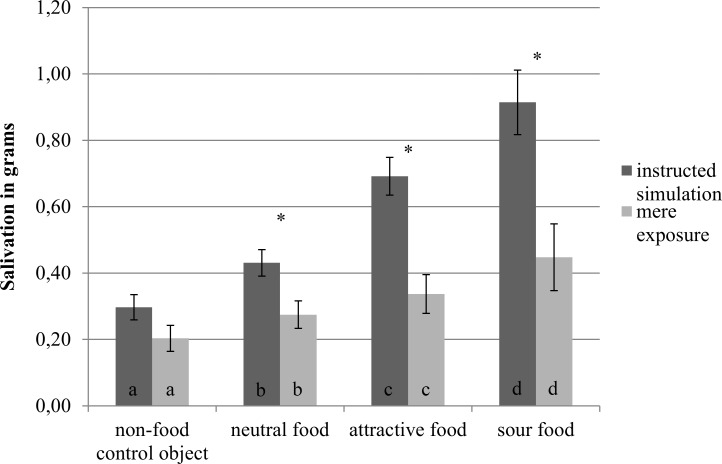
Salivation by object type and condition in Experiment 2.Different letters indicate significant differences between objects within a condition, p < .05. Asterisks indicate significant differences between conditions for an object, p < .05. Error bars represent standard errors from the mean.